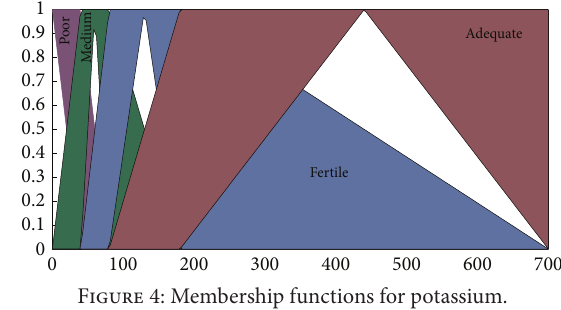
Figure 2: Membership functions for nitrogen.